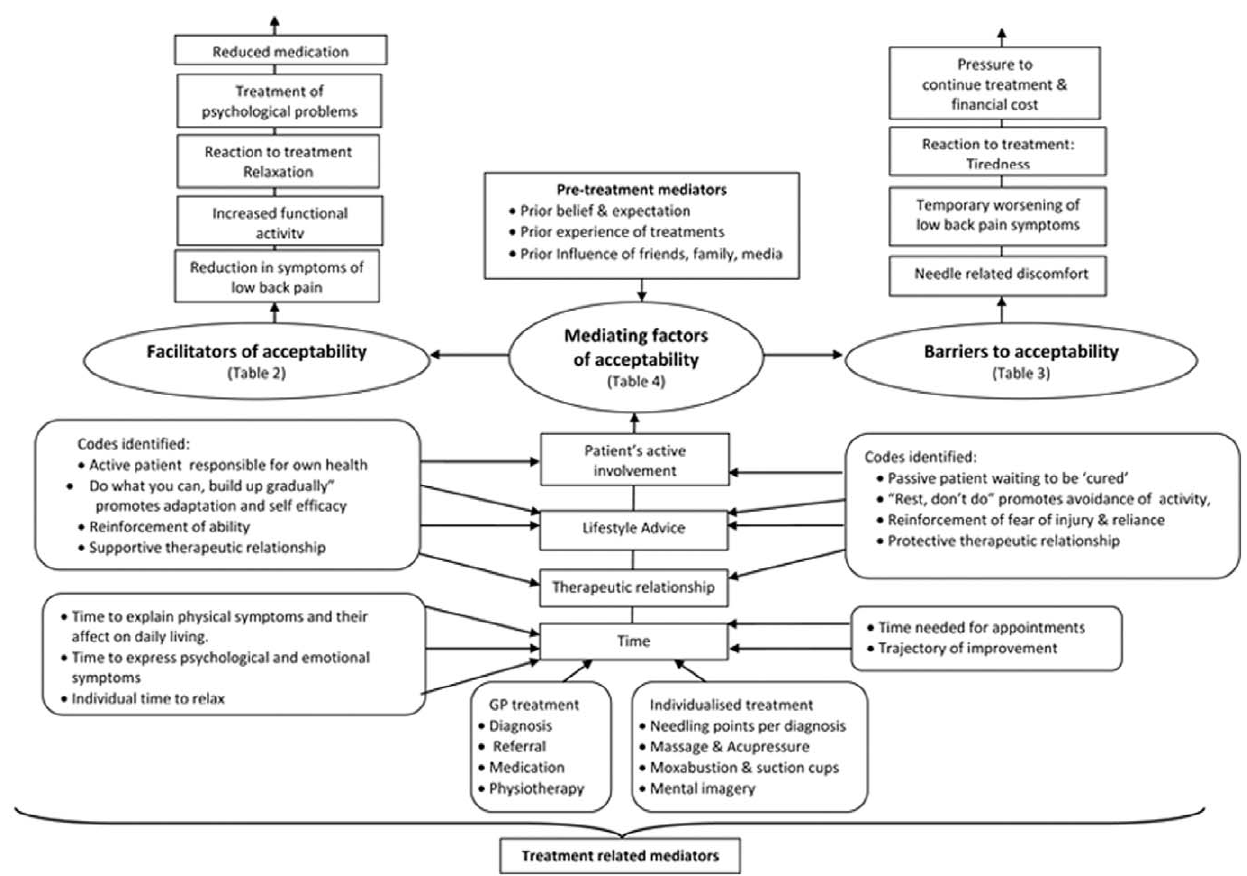
Figure 1. Initial thematic map showing three over-arching themes and related subthemes.